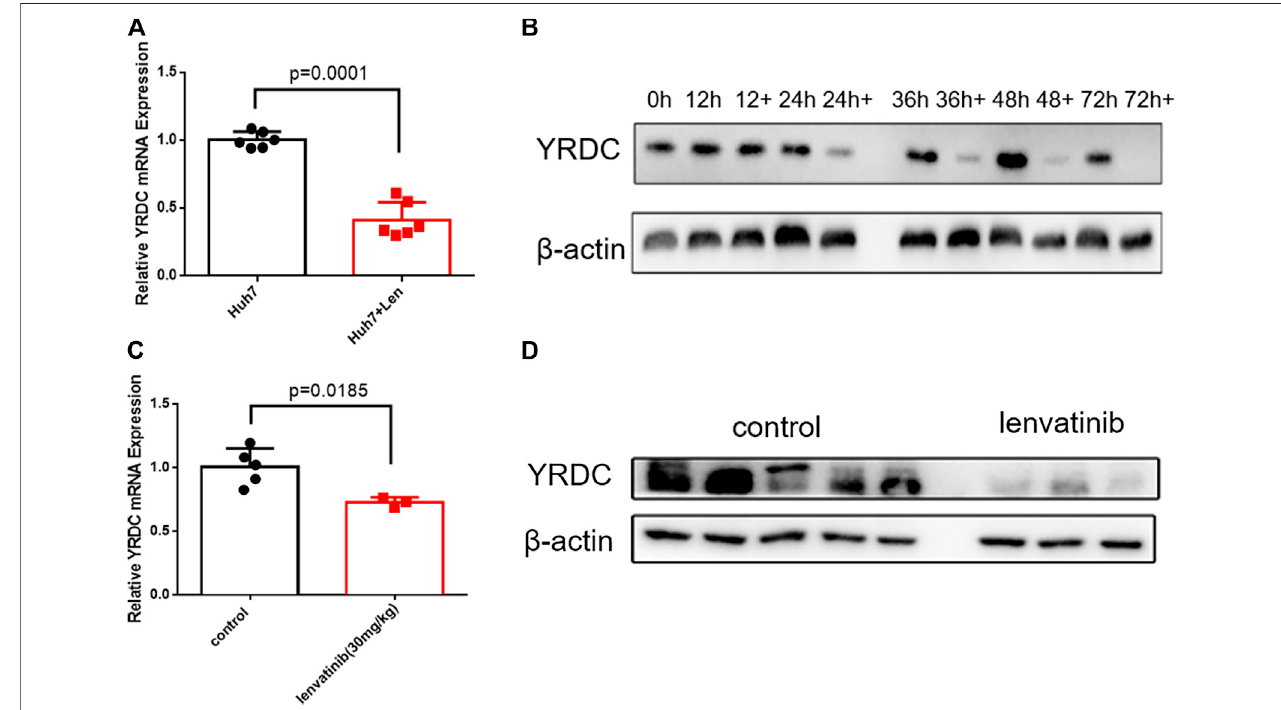
FIGURE 5 | YRDC might be the target of anticancer of lenvatinib. (A) qPCR analysis for levels of YRDC in Huh7 cells with lenvatinib (0.8 μ M) as well as the corresponding vehicle control, n (cid:2) 6. (B) Lenvatinib (0.8 μ M) inhibits the expression of YRDC in a time-dependent manner in Huh7 cells. (C, D) Lenvatinib inhibits the expression of YRDC in the xenograft of Huh7 cells in null mice, n (cid:2)